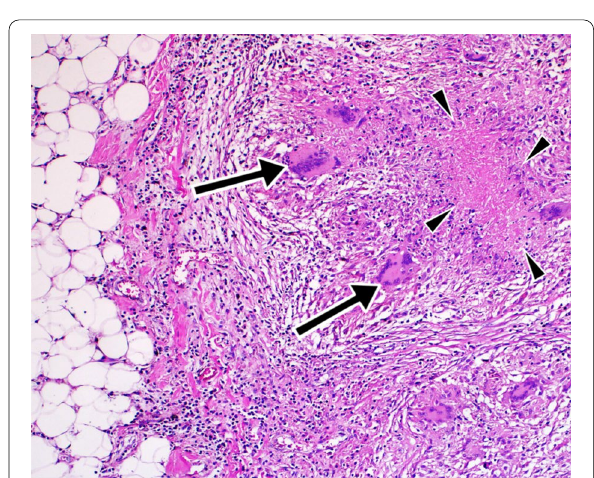
Fig. 14 Histopathologic evaluation (Hematoxylin Eosin tru-cut biopsy specimen demonstrates granuloma with Langshan’s giant cells (arrows) and caseous necrosis (arrowheads) in lipomatous tissue, compatible with